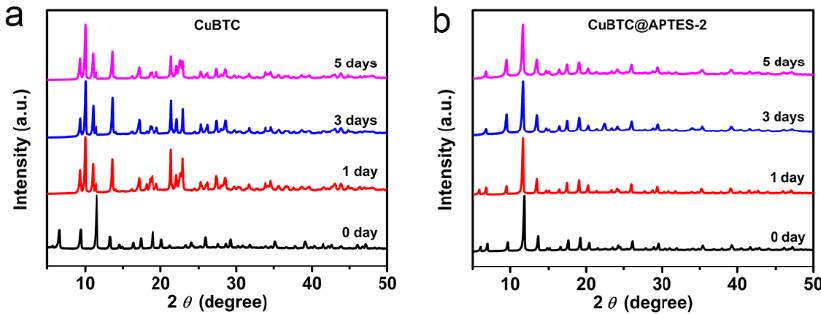
Figure 5. XRD patterns of samples after submersion in water ( a ) CuBTC; ( b ) CuBTC@APTES-2.